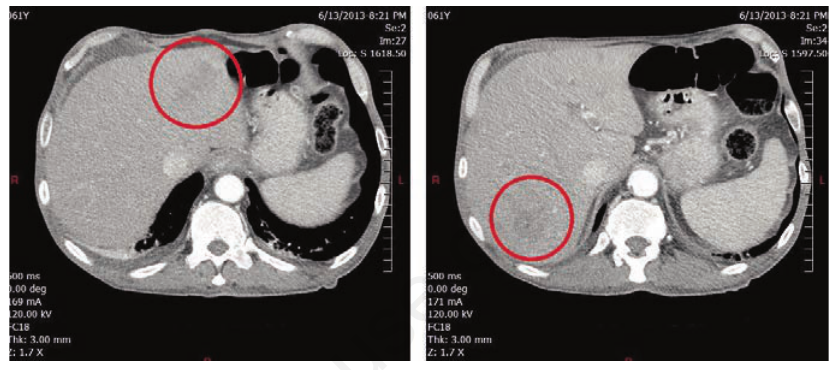
Figure 1. Ill defined lesions seen in the liver.